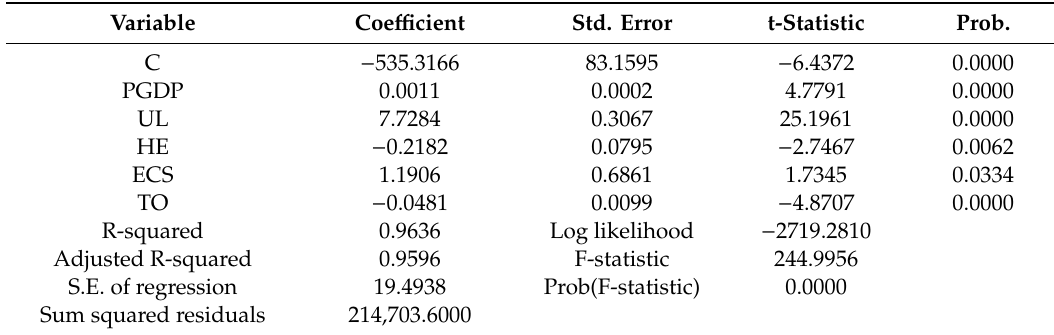
Table 7. Regression